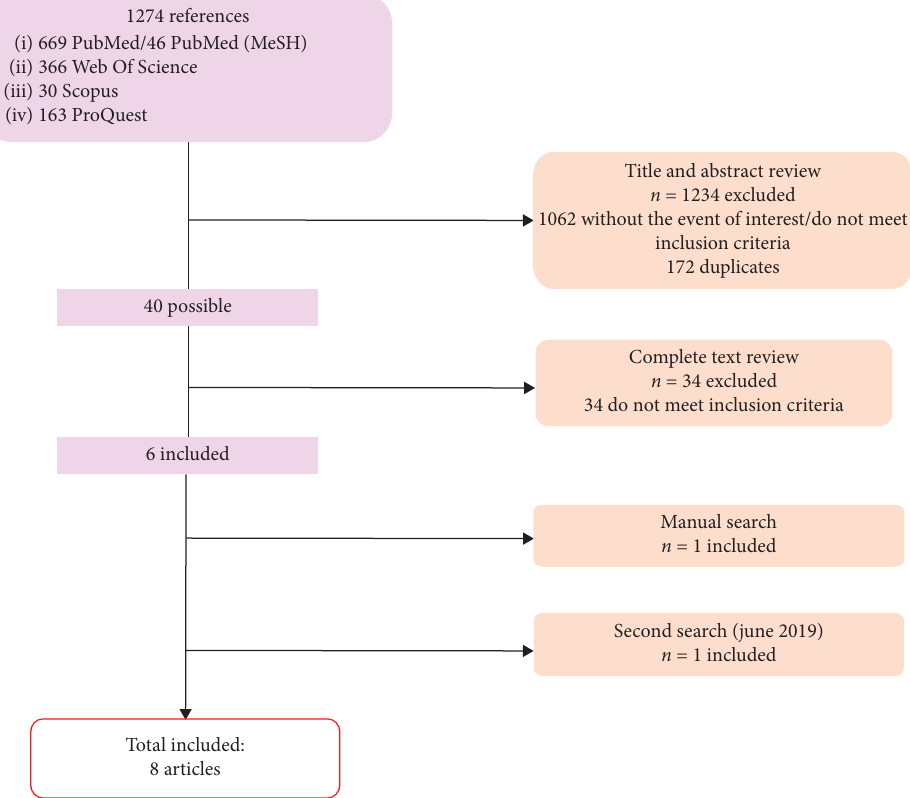
Figure 1: Flowchart showing the procedure followed during the systematic